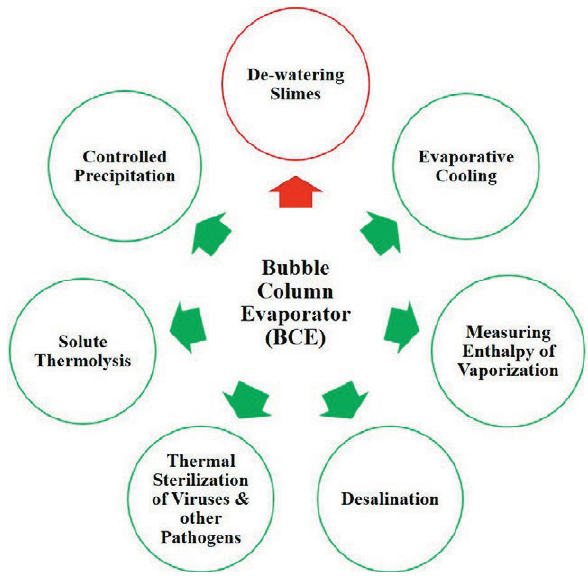
Figure 1. Different applications for the BCE